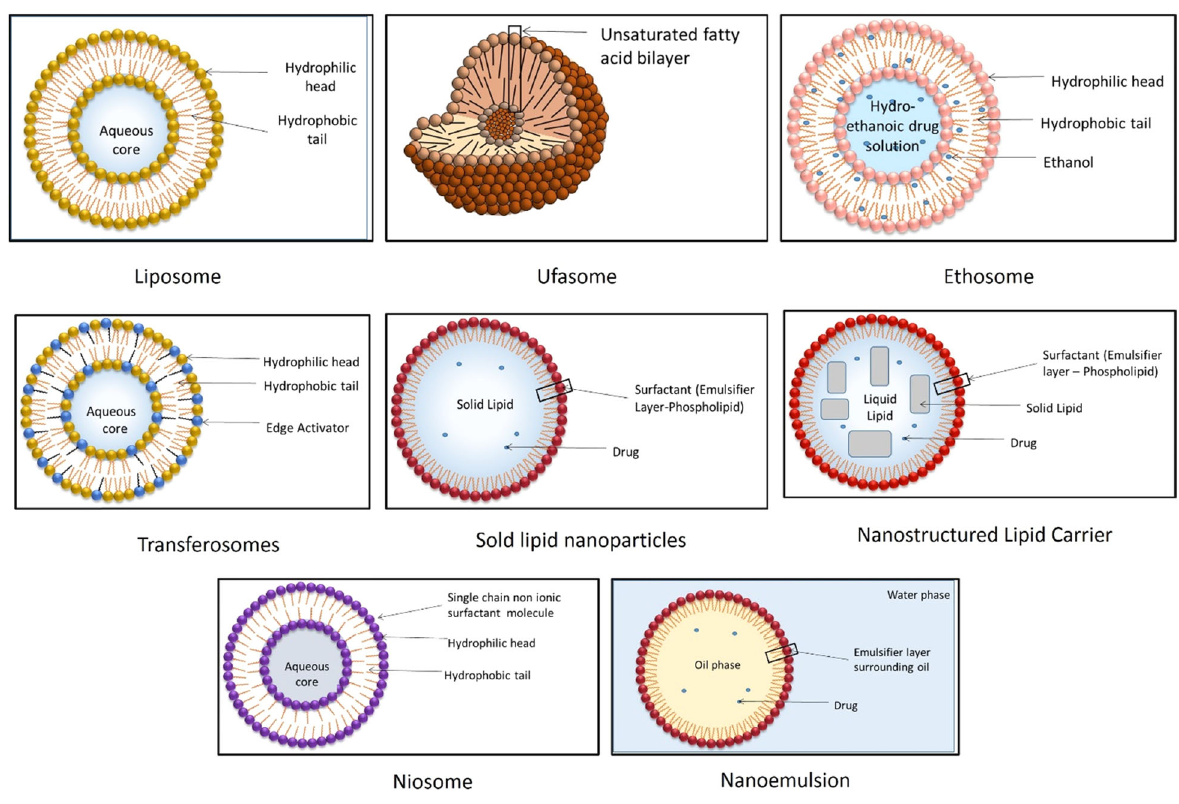
Fig. 2 Lipidic nanocarrier delivery systems for TCS